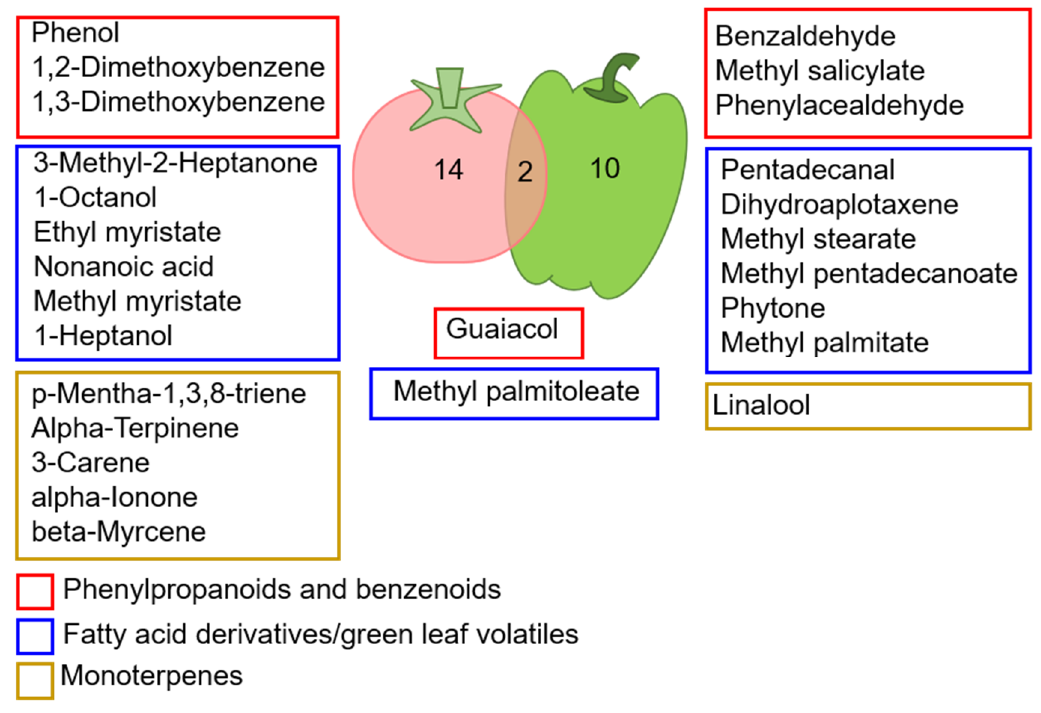
Figure 4. Venn diagrams of all VOCs altered in tomato and pepper plants post inoculation with non-viruliferous/viruliferous whiteflies versus the non-inoculated control.